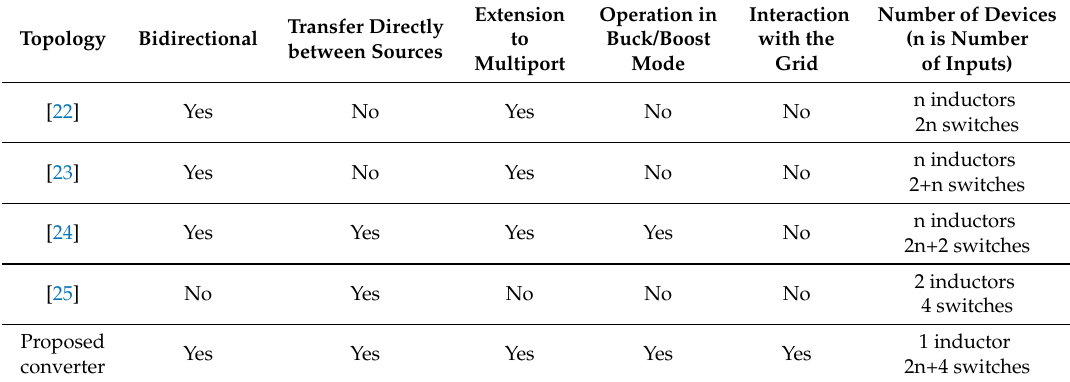
Table 1. Comparison of the proposed converter with the existing